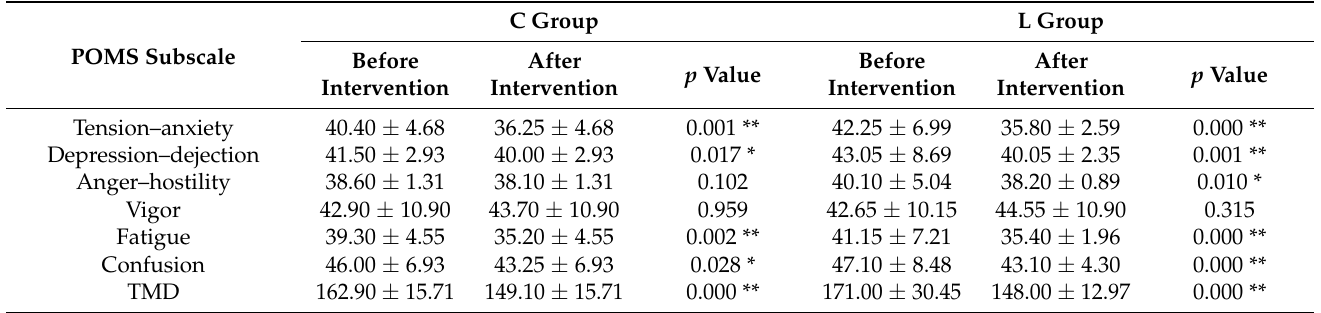
Figure 2. Changes in the HF, LF/HF, and TP values by footbath with or without Lu essential oil (n = 20). Before: before taking a footbath (Before the intervention), Footbath: during taking a footbath, After: after taking a footbath (after the intervention). HF: High-frequency value, LF/HF: Low-frequency/high-frequency value ratio, TP: Total power. The HF power spectrum is 0.15–0.4 Hz and reflects the parasympathetic nervous system activity. * p < 0.05 between before and after using repeated measures ANOVA and Bonferroni test. Table 1. Changes in the POMS scores (n =